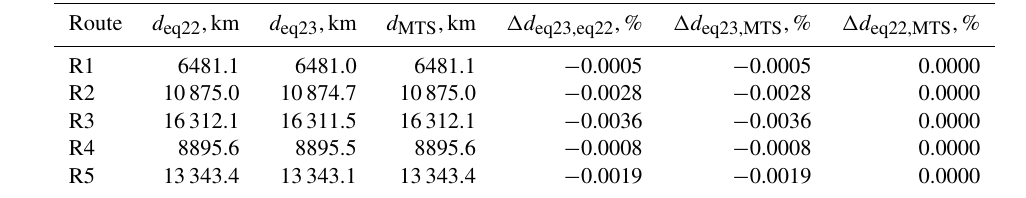
Table 4. Great circle distance ( d ) of the five representative routes calculated with different calculation methods. Column 2 ( d eq22 ) corresponds to the result calculated by Eq. (22); column 3 ( d eq23 ) corresponds to the result calculated by Eq. (23) with n wp = 100; and column 4 ( d MTS ) shows the result calculated with the Movable Type scripts (MTS), using the Haversine formula with a spherical Earth radius of R E = 6371km. (d eq23 − d eq22 ) In columns 5 to 7: (cid:49)d eq23,eq22 = d eq22